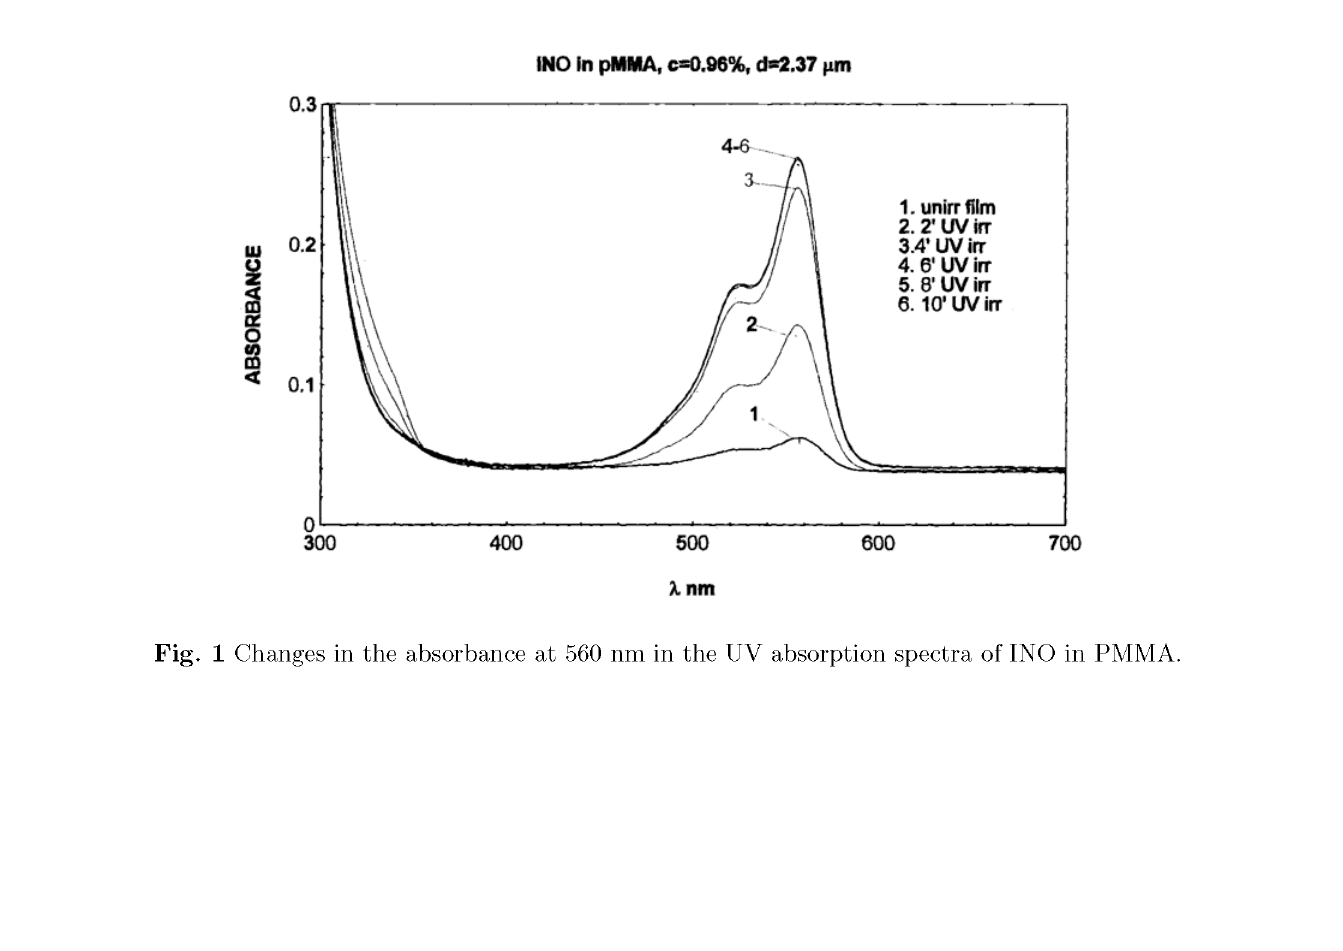
Fig. 1 Changes in the absorbance at 560 nm in the UV absorption spectra of INO in